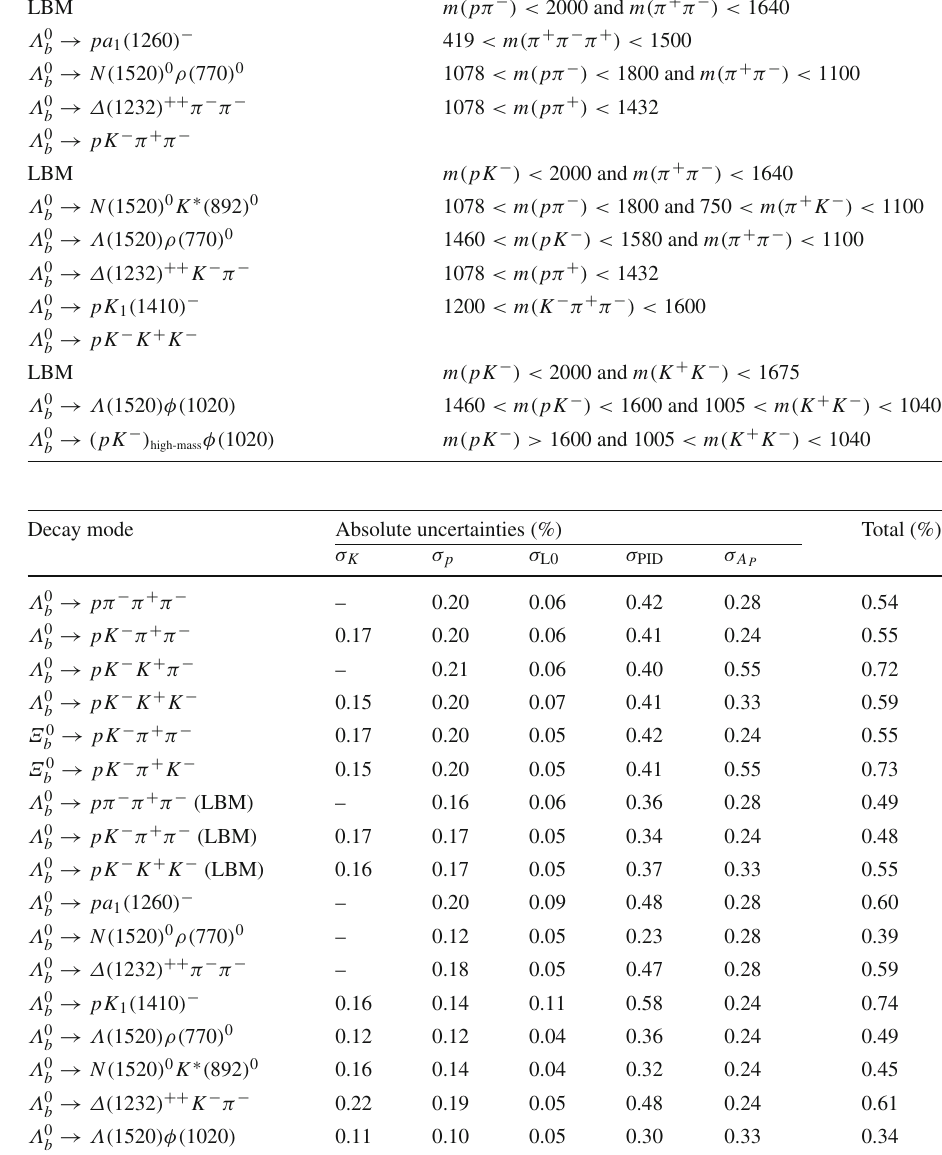
Decay mode Invariant-mass requirements (in MeV/ c 2 ) requirements applied for the different phase-space selections for each final state considered